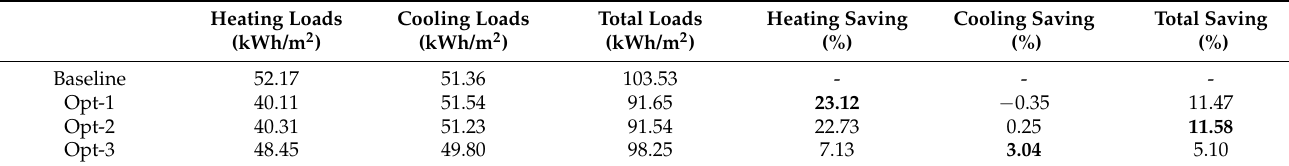
Table 6. Performances of the optimized designs for Case A. The best design for each case is in bold. Heating Loads